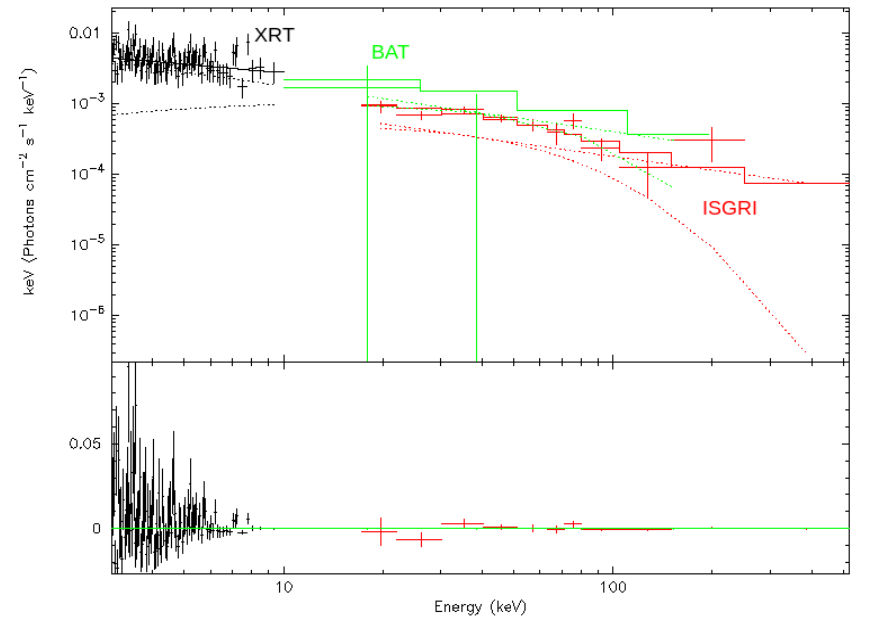
Figure A4. Unfolded SWIFT/XRT, SWIFT/BAT and INTEGRAL/ISGRI spectra of 3C 111 during 4th (November 2008) observational period and model. Above: all the spectra are shown by crosses; fitting curves are shown by solid lines; model components are shown by dotted lines; below: data residuals. During this period jet base emission was dominating significantly over nuclear one (the jet base flux in 5–7 keV range was more than three times higher than the nuclear one); emission in Fe-K α line was